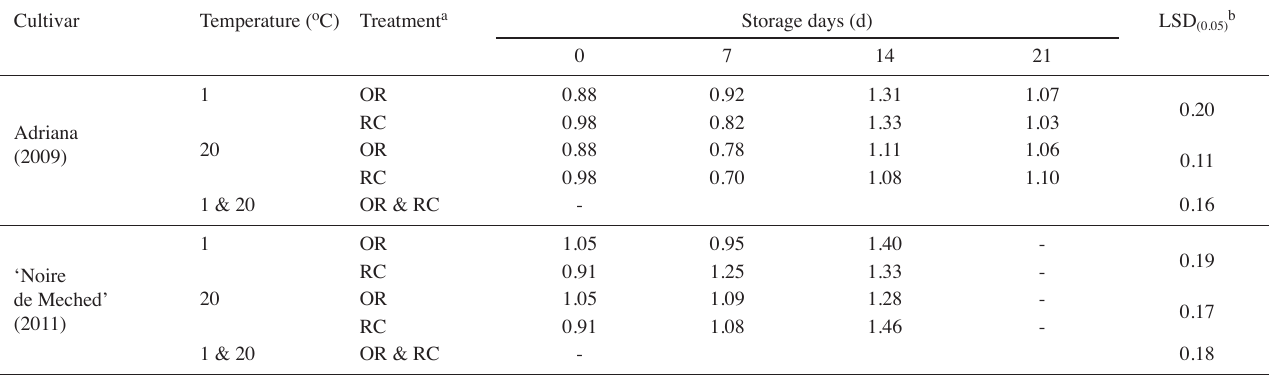
Tab. 3: Effects of rain cover on respiratory quotient (RQ) values in Adriana’ and ‘Noire de Meched’ cherries at harvest, during and after storage.